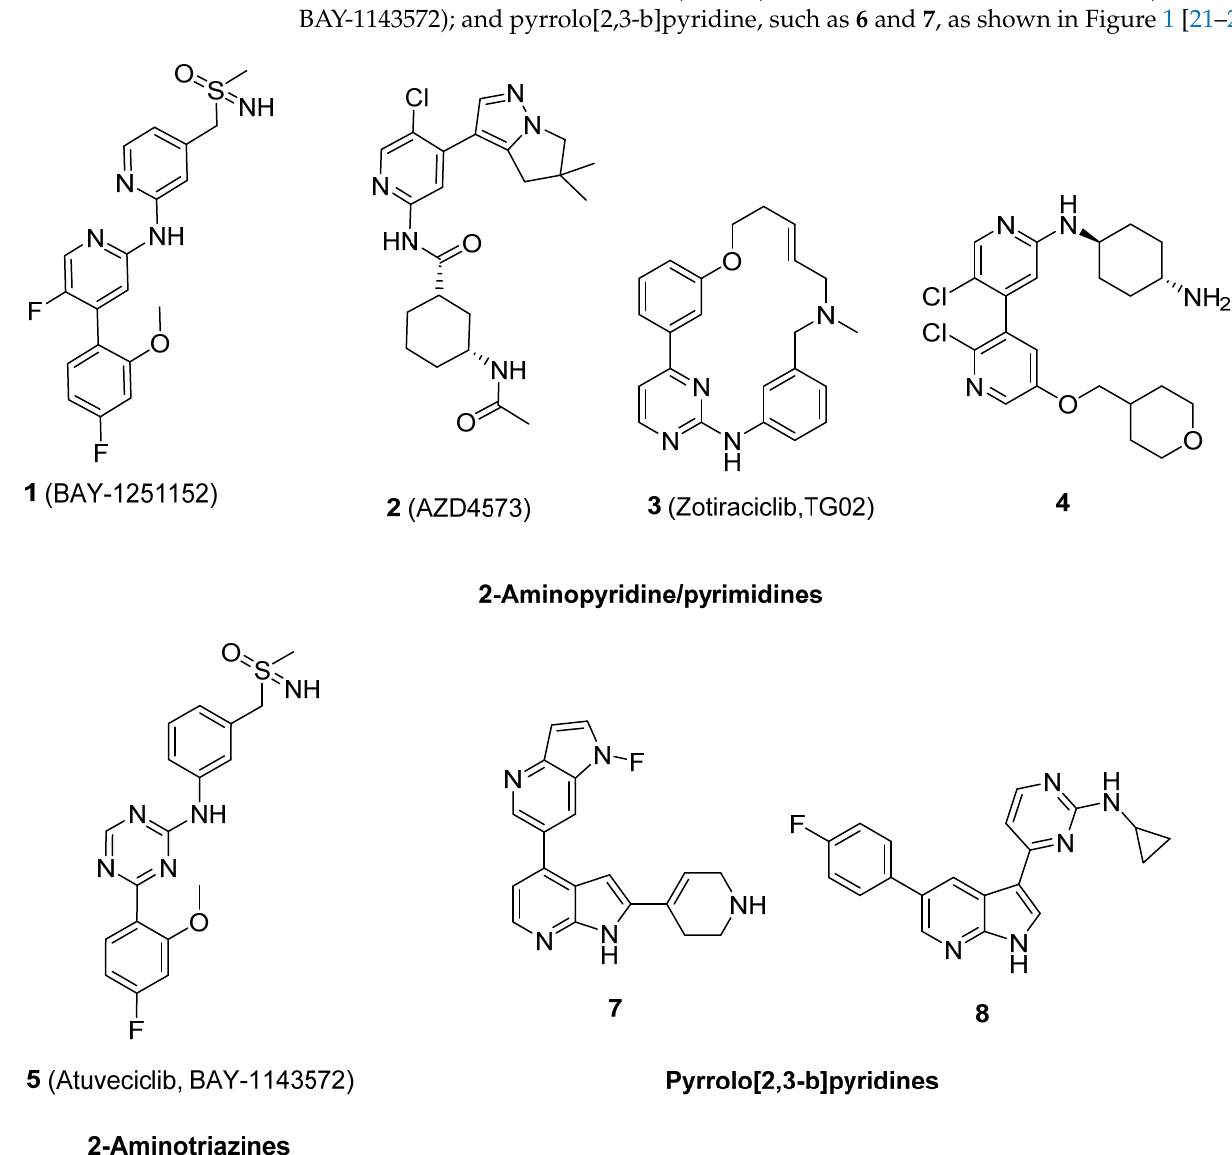
Figure 1. The main scaffolds of currently available clinical and patent CDK9 inhibitors.